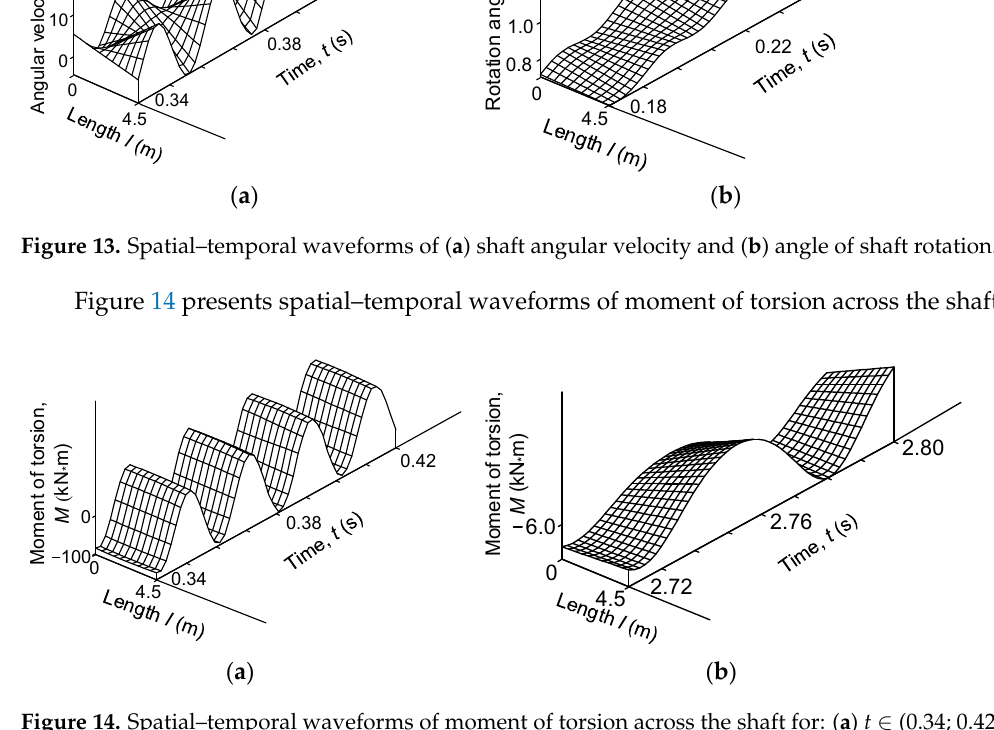
Figure 14. Spatial–temporal waveforms of moment of torsion across the shaft for: ( a ) t ∈ (0.34; 0.42) D = 0.1825 m α 1,2 = α 2,3 = π /5; ( b ) t ∈ (2.72; 2.80): D = 0.3 m α 1,2 = α 2,3 = π /5.